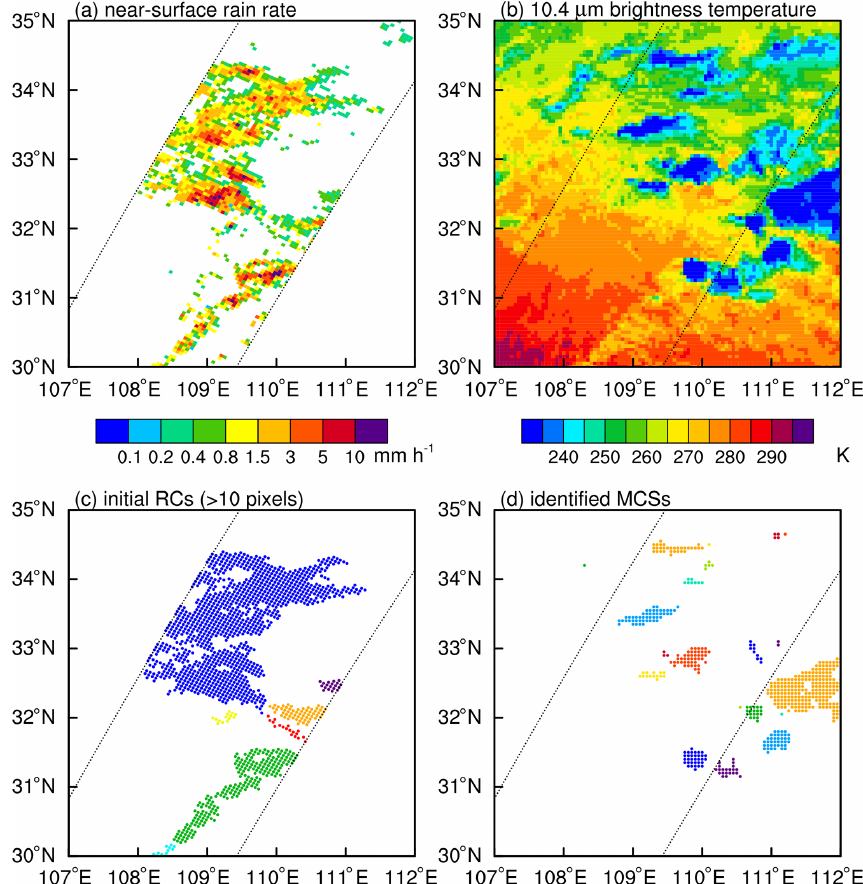
Figure 3. Horizontal distributions of the (a) near-surface rain rate, (b) 10.4µm brightness temperature, (c) initial RCs, and (d) identified MCSs for the precipitation event occurring at 10:08UTC on 1 June 2016. The adjacent dots of different colors in panels (c) and (d) indicate different RCs or